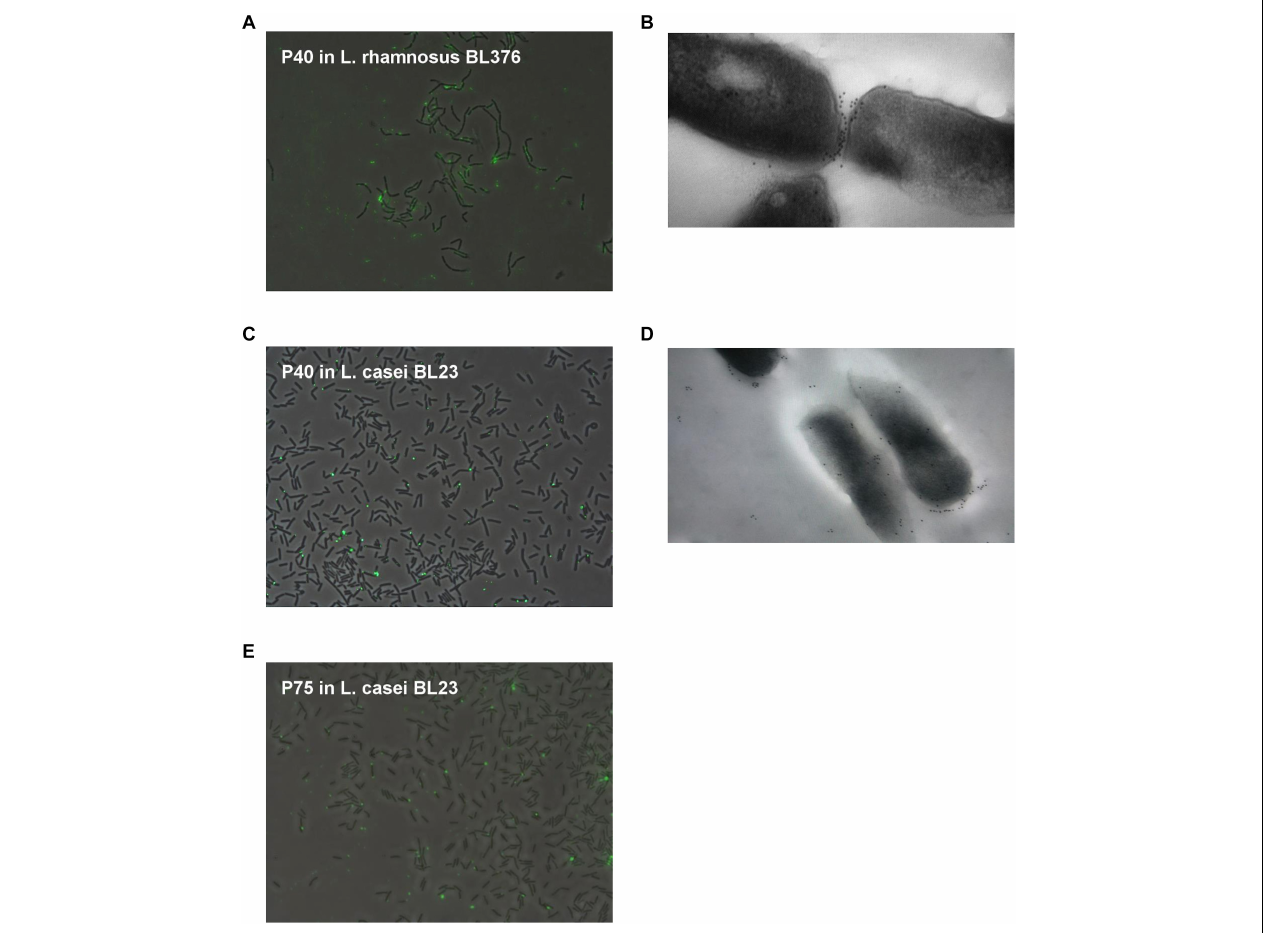
FIGURE 4 | Localization of P40 in L. casei BL23 and L. rhamnosus GG with anti-P40N antibodies, and P75 in L. casei BL23 with anti-P75N antibodies. (A–C) Show random epifluorescence microscopic fields of Alexa immune labeled P40 on L. casei BL23 and L. rhamnosus BL376 (LGG); (E) of P75 in L. casei BL23; and (B,D) show TEM of L. casei BL23 and L. rhamnosus BL376 (LGG) subject to immunogold staining of